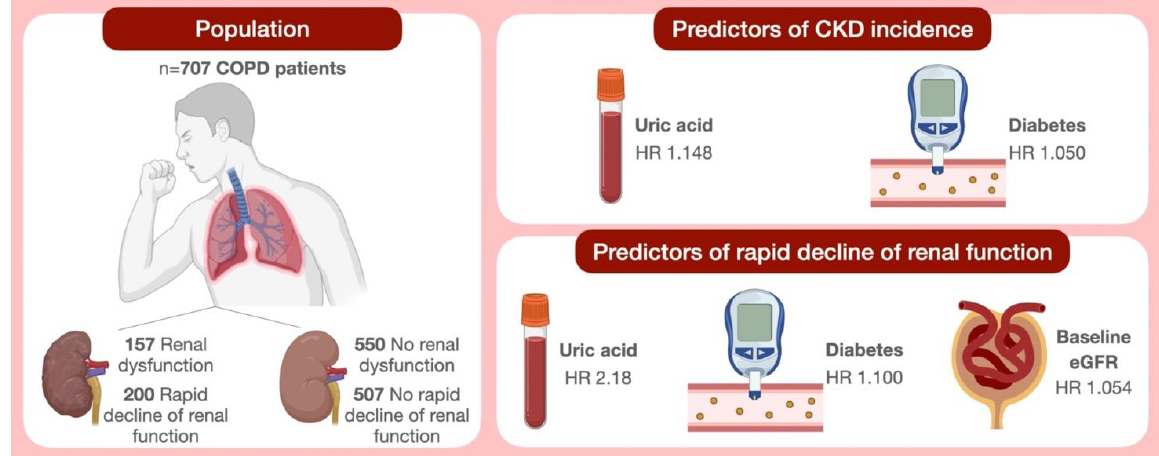
Figure 2. Schematic illustration of study findings. Abbreviations: COPD, chronic obstructive pulmonary disease; CKD, chronic kidney disease; eGFR, estimated glomerular filtration rate; HR, hazard ratio.